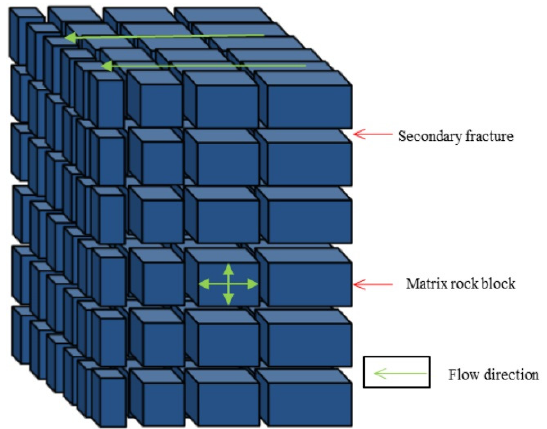
Figure 1. Non-uniform fracture network structure model.